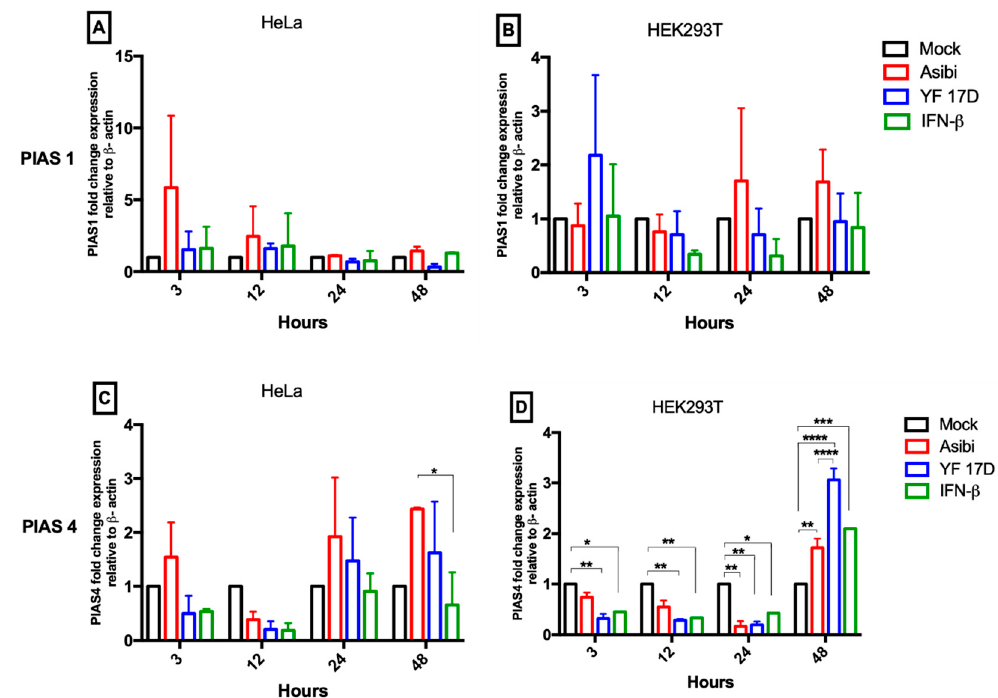
Figure 4. Expression dynamics of PIAS genes. Hela and HEK293T cells were infected with either Asibi or YF-17D at MOI = 1. Positive control cells were stimulated with IFN- β while unstimulated uninfected cells served as negative controls. At the indicated time points, cells were processed, and RNA extracted. Expression levels of PIAS1 ( A , B ) and PIAS4 ( C , D ) were determined by RT-qPCR and expressed as fold change difference with β -actin as endogenous control. Data represent two independent experiments performed in triplicates and are presented as mean ± SEM. * = p ≤ 0.05, ** = p ≤ 0.01, *** = p ≤ 0.001, **** = p ≤ 0.0001.